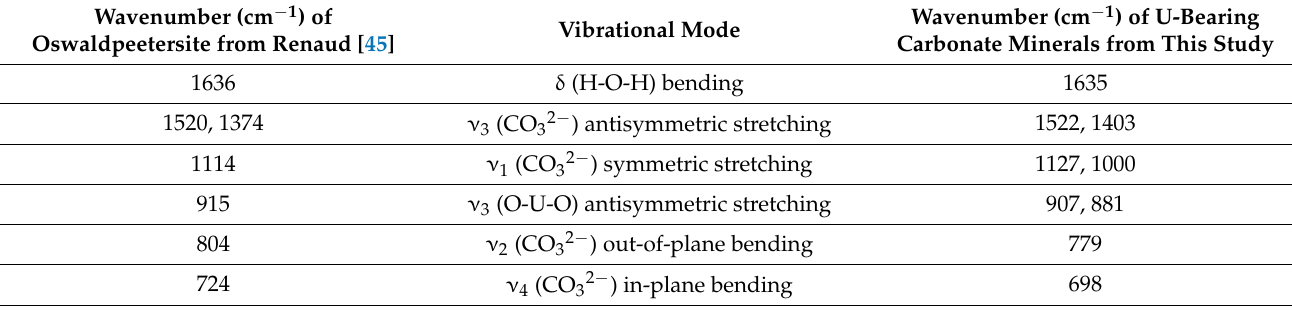
Table 1. Analyses result of an infrared-absorption spectrum of U-bearing carbonate minerals.